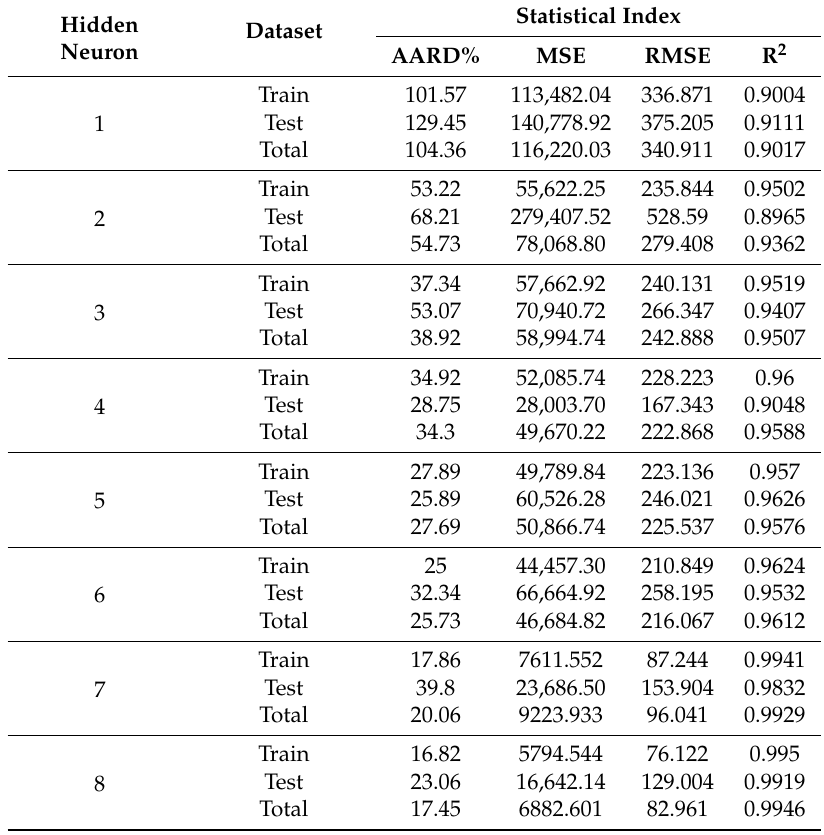
Table 4. Determining the greatest hidden neurons for multilayer perceptron